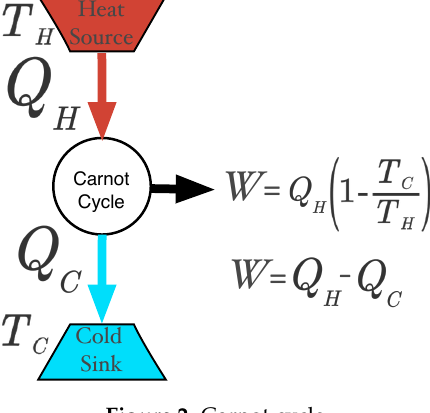
Figure 2. Carnot